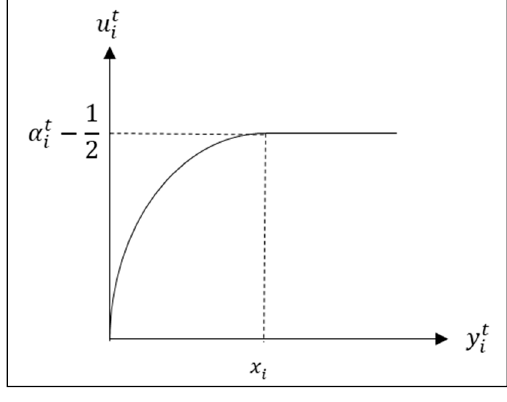
Figure 2. Utility function.